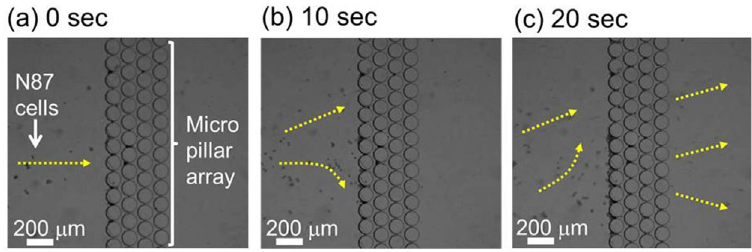
Figure 9. Serial images of the motions of N87 cells introduced into a microchamber with a micropillar array. ( a ) The cells flow straight towards the micropillar array. ( b ) Once they reach the micro pillar array at 10 s, the spread of the cells widens. ( c ) The cells after the micropillar array spread at 20 s. Yellow arrows indicate the direction of cell